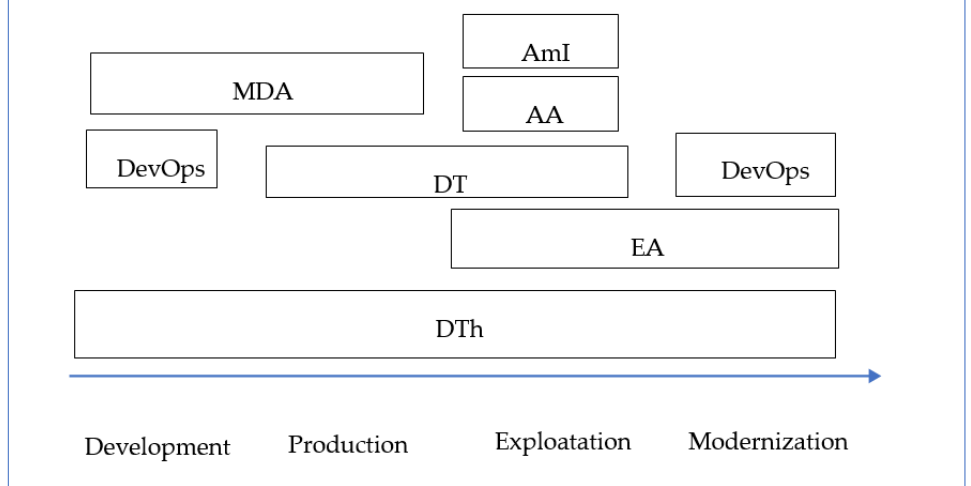
Figure 1. The use of the paradigms related to different stages of the LC.